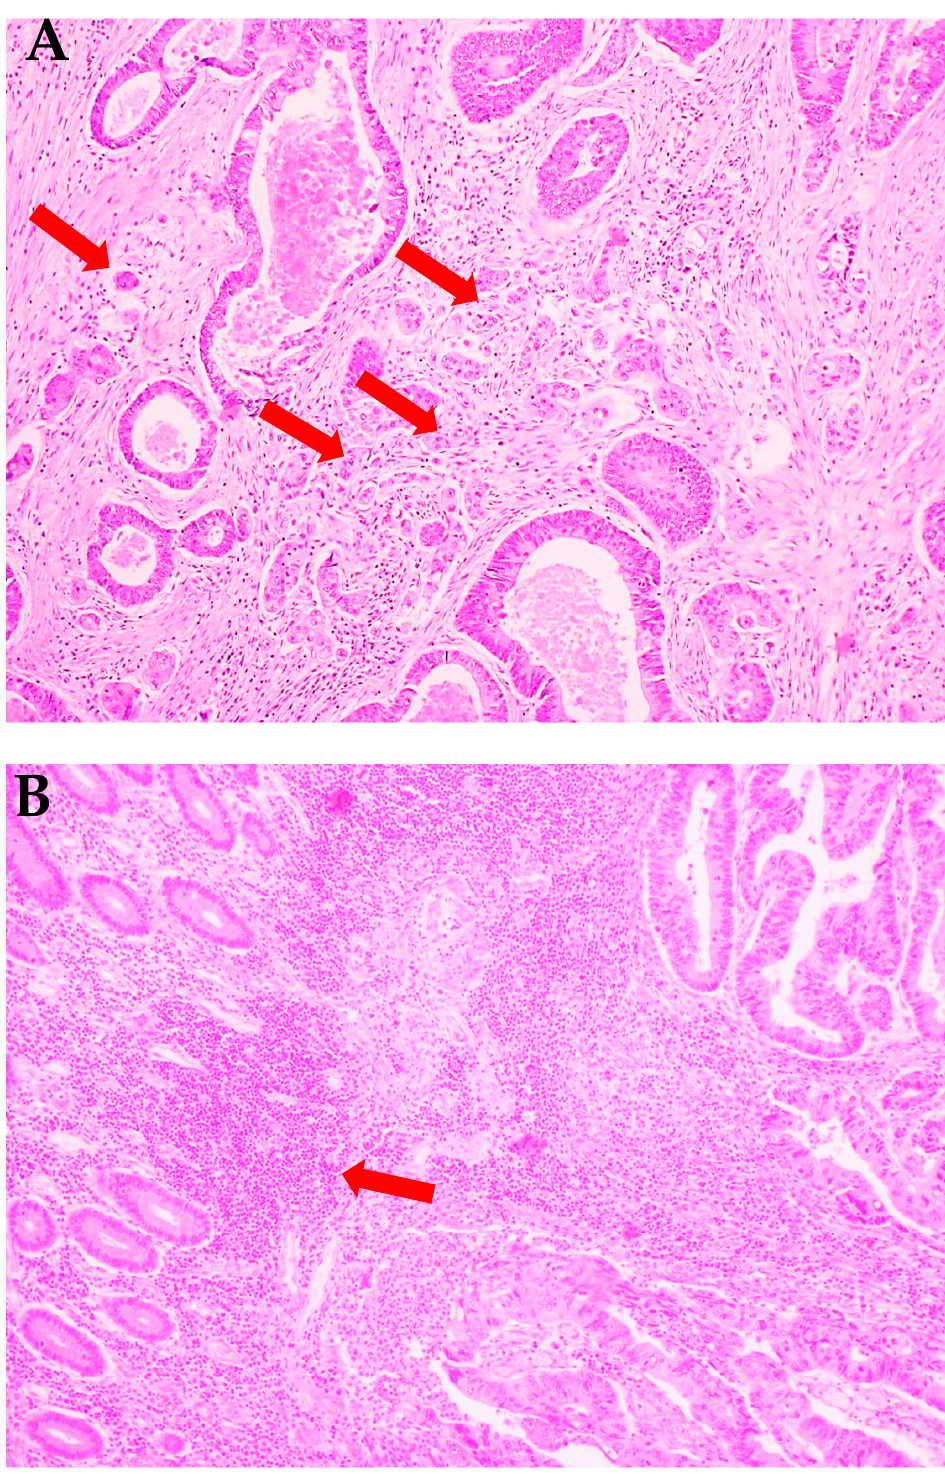
Figure 1. Histological images of colorectal cancer. ( A ) Colorectal adenocarcinoma with budding foci (red arrows). ( B ) Colorectal adenocarcinoma with strong inflammatory cells infiltration (red arrow). H+E staining. 200× magnification.